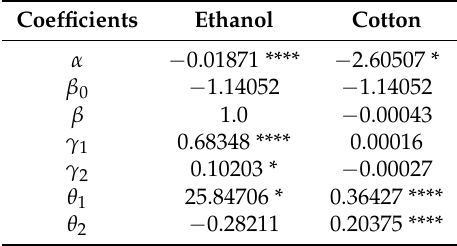
Table 3. The vector error correction models (VECM) for the ethanol (ETH)-cotton (COT) pair in P 1 . Significance levels: 10% (*), 5% (**), 1% (***) and 0.1%